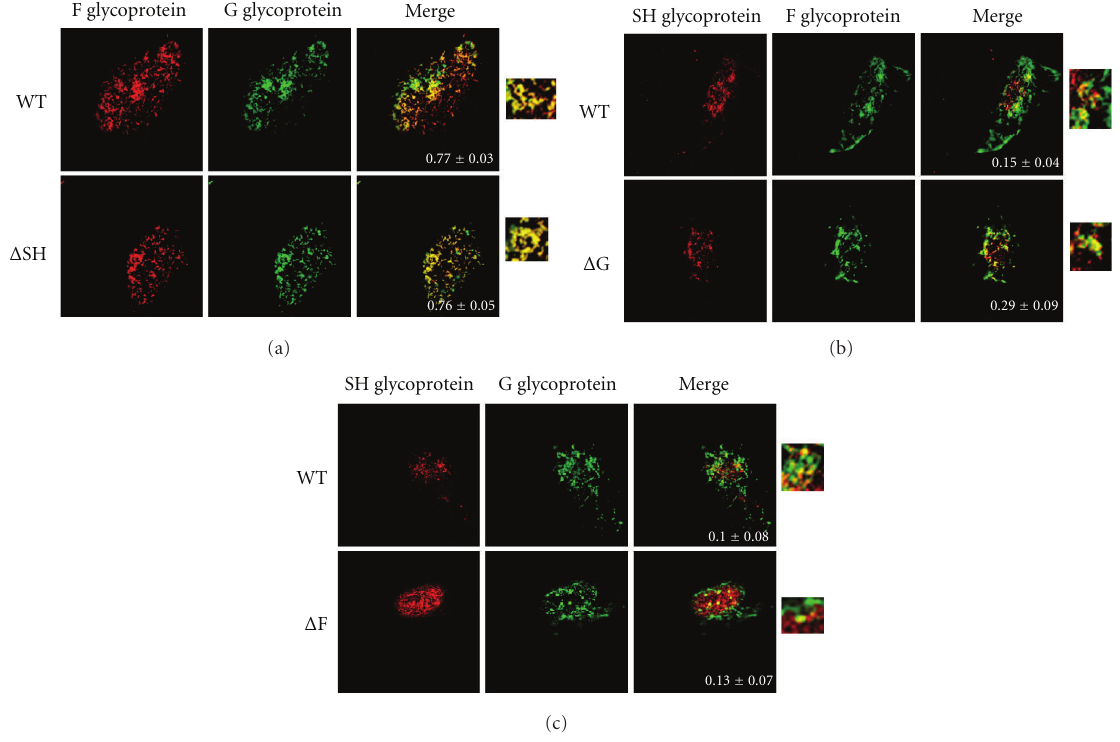
Figure 3: E ff ect of the deletion of individual glycoprotein genes on the colocalization of pairs of HRSV glycoproteins at the plasma membrane. Localization of HRSV glycoproteins at the site of viral assembly by confocal microscopy. A549 cells infected with WT or glycoprotein deleted HRSV as indicated at a MOI 0.2 were fixed, permeabilized, and incubated with primary antibodies against two di ff erent glycoproteins. (a) Staining of F and G glycoproteins where F is shown in red and G in green. (b) Staining of SH and F where SH is shown in red and F in green. (c) Staining of SH and G where SH is shown in red and G in green. A merge of the two stains is shown in the right row. A blowup of the merge is also shown. Images were taken on a Zeiss confocal microscope. An average of twelve cells were imaged per staining, and colocalization was measured using ImageJ and JACoP plugin. Pearson’s coe ffi cient ± standard error of mean is shown within the merge